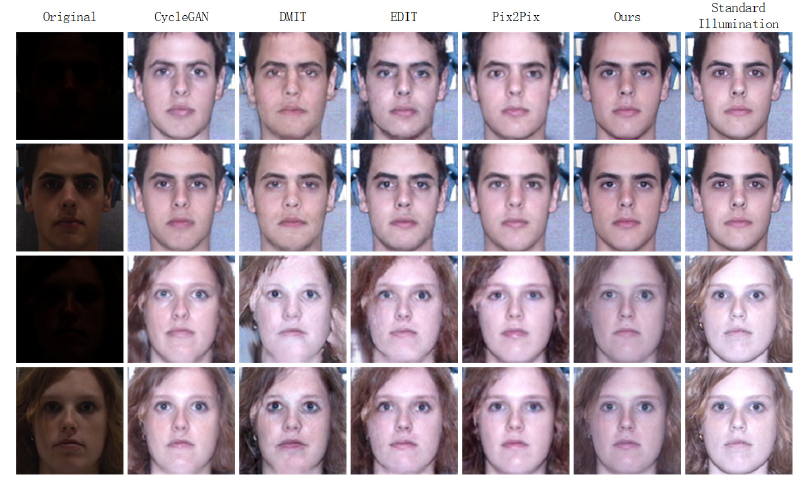
Figure 5. Comparisons between the CycleGAN [13], the DMIT [14], the EDIT [15], the Pix2Pix [16] and ours on the MultiPIE database. The first column: original poor-lighted face images. The second to sixth columns: synthesized results of the original poor-lighted face images.